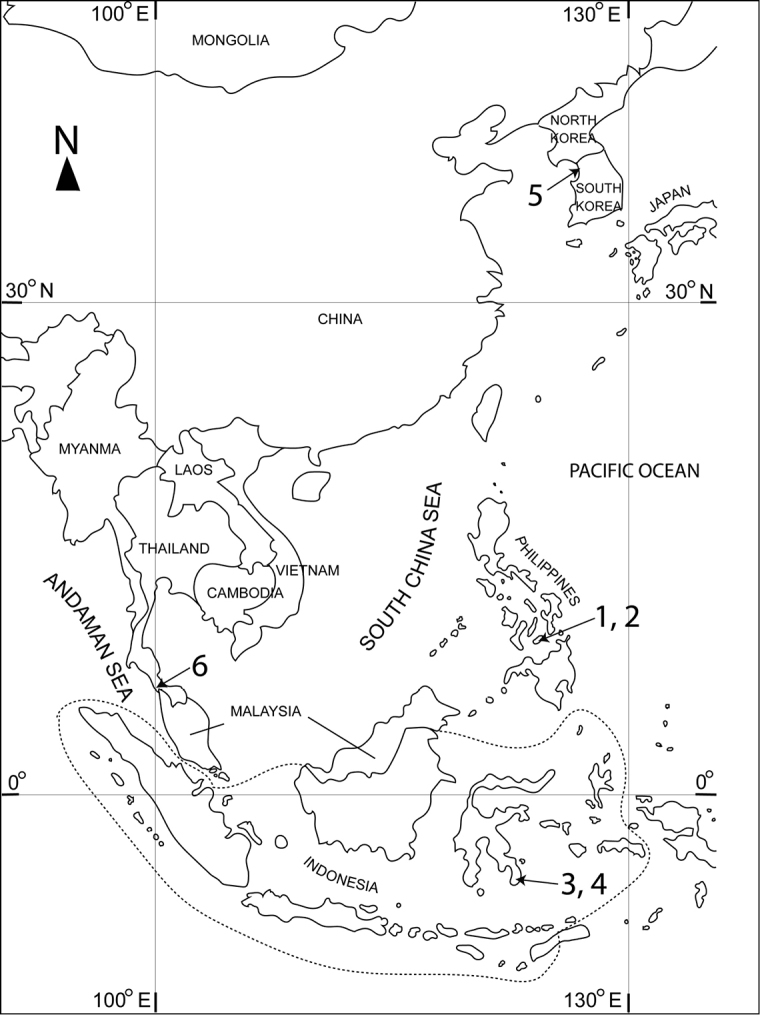
Distribution of the representatives of the genus Boholina: 1B.
crassicephala2B.
purgata3B.
parapurgata4B.
munaensis5B.
ganghwaensis6B.
laorsriae sp. nov.